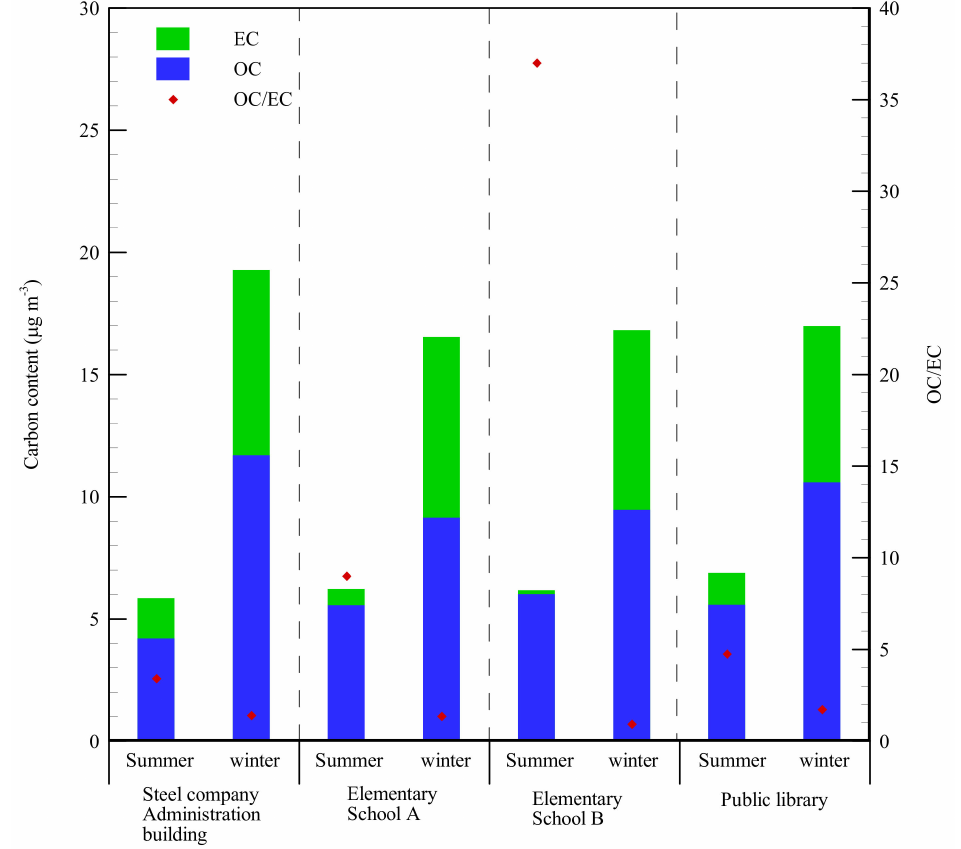
Figure 6. Mass of elemental and organic carbon in TSP and the ratios of OC/EC at the steel